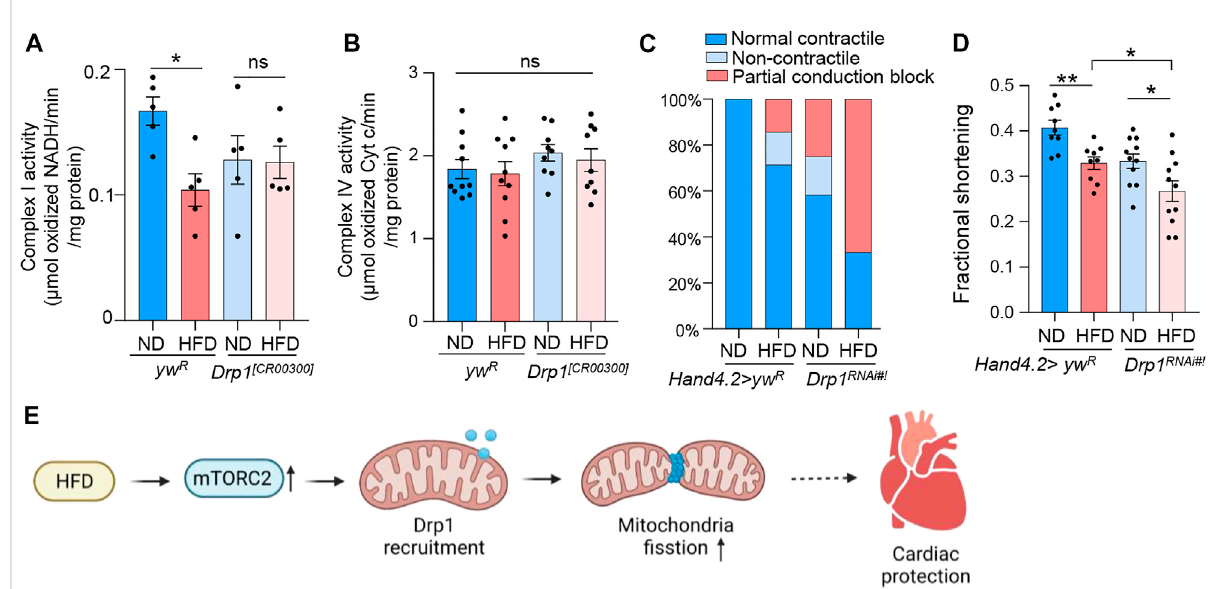
FIGURE 5 Drp1 regulates mitochondrial and cardiac dysfunction under HFD treatment. (A) The complex I activity of the wild-type and Drp1 mutant fl ies underNDorHFDtreatment.Two-wayANOVA:Interactionbetweendietandgenotypeissigni fi cant, p =0.05.Tukey ’ smultiplecomparisontest:* p < 0.05,ns:notsigni fi cant.N=5~6(5~6replicates,20 fl iesperreplicate).Thecontrolgroupre-usesthedatafromFigure2A. (B) ThecomplexIVactivity ofthewild-typeand Drp1 mutant fl iesunder ND orHFD treatment. Two-way ANOVA: Interaction between dietand genotype is notsigni fi cant,